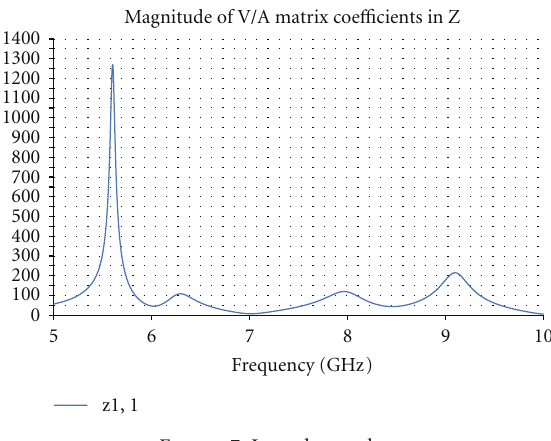
Figure 7: Impedance plot.